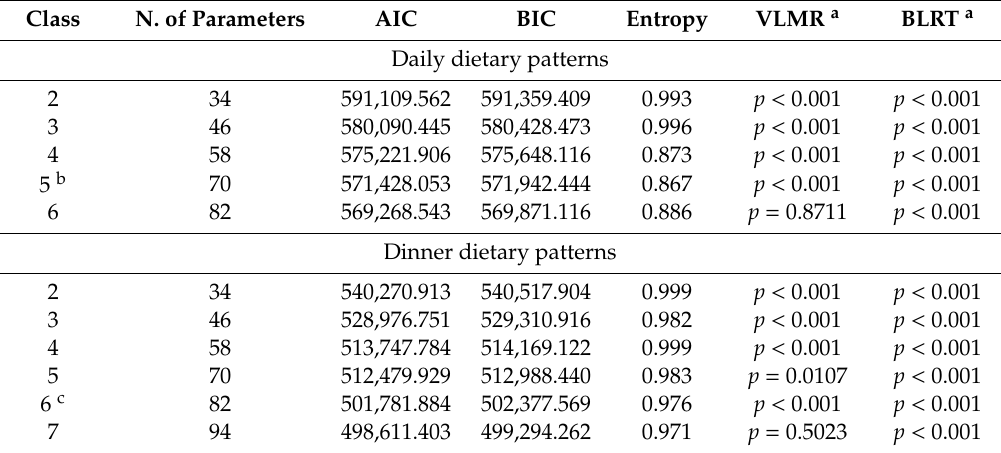
Table 3. Model fit information for LCPA models fit to data.